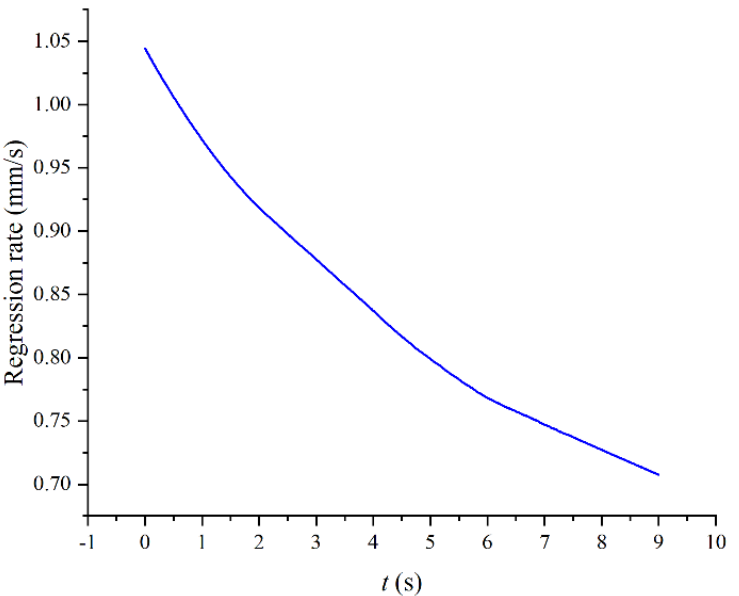
Figure 16. The regression rate of this HRM with time. Table 3. Results of firing test and numerical